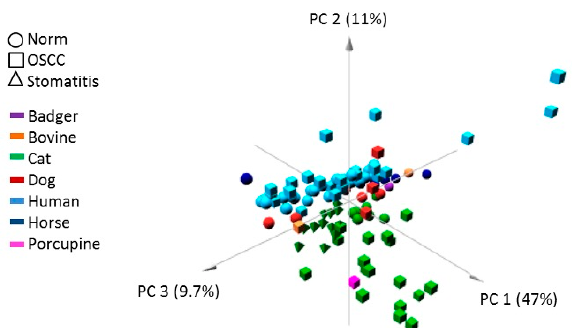
Figure 4. PCA results for the three different types of tissue. Only for display purposes, different species are highlighted with different colors. Unit variance scaling was applied to rows and Singular value decomposition (SVD) with imputation was used to calculate principal components. X , Y, and Z axes show principal components 1, 2, and 3 that explain 47%, 11%, and 9.7% of the total variance, respectively.